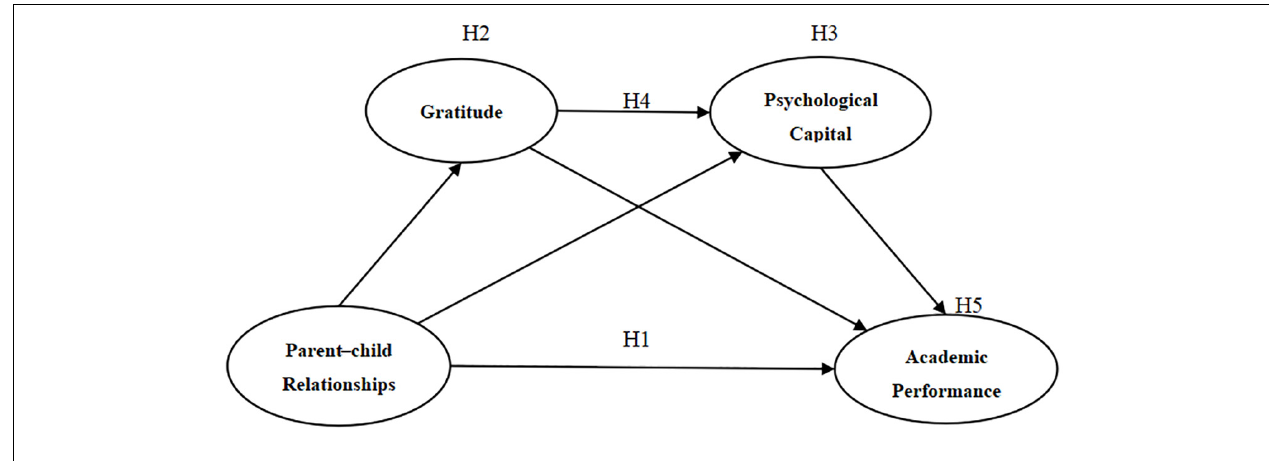
FIGURE 1 | Hypothetical model. TABLE 1 | Confirmatory factor analysis of the questionnaire of college students’ parent–child interaction.